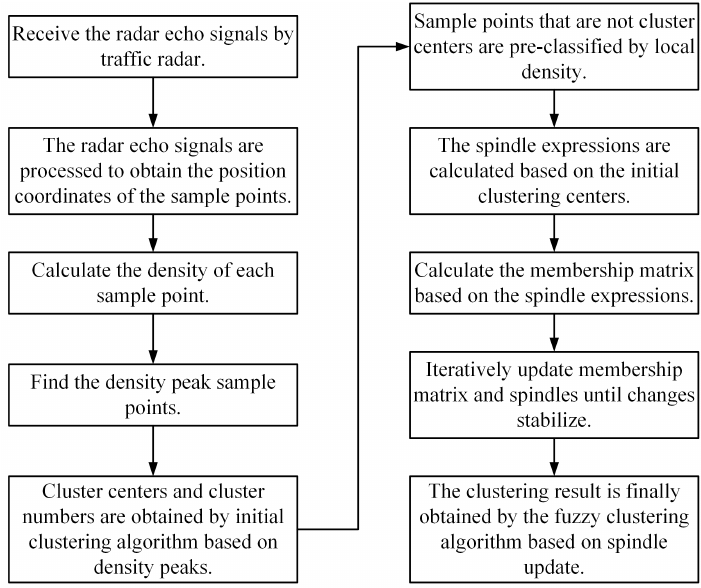
Figure 1. The main diagram of the system.